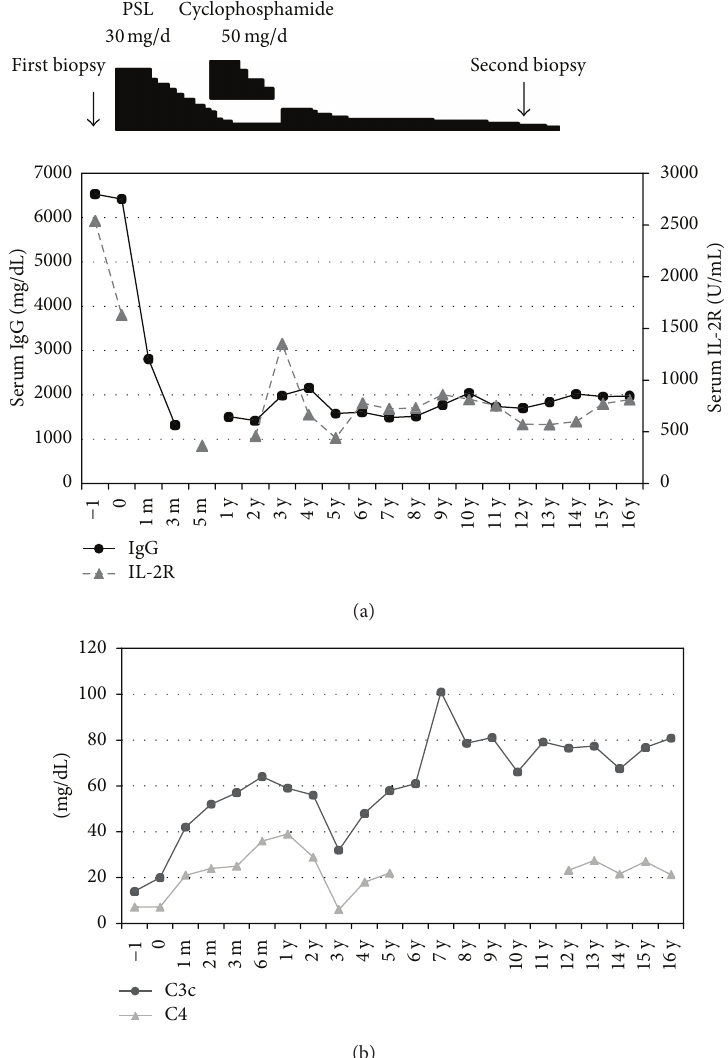
Figure 3: (a) Clinical treatment and serum IgG and IL-2R levels at followup. (b) Serum C3c and C4 levels at followup. PSL: